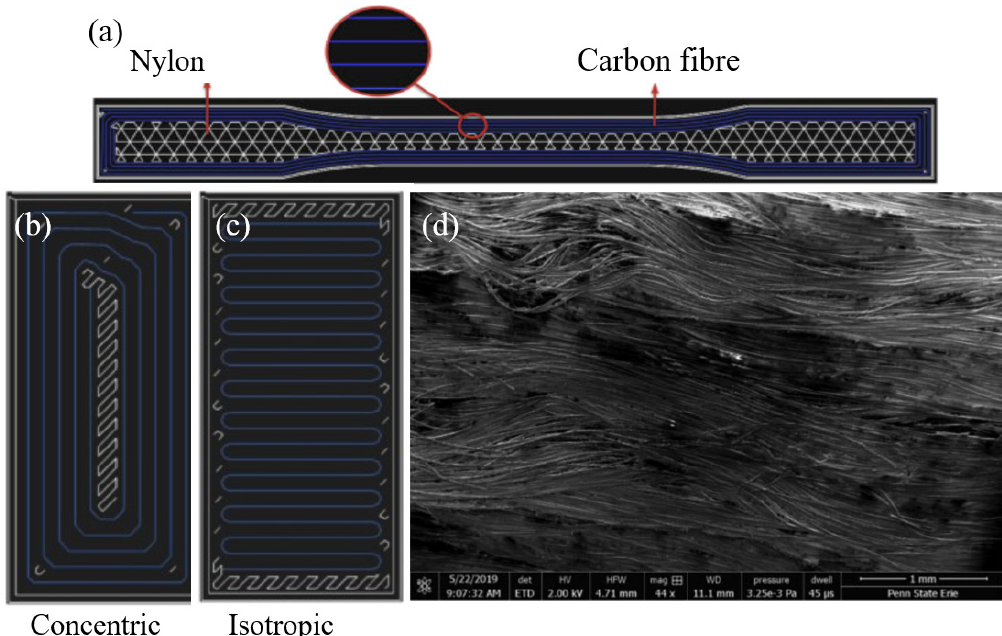
Figure 10. ( a ) Continuous carbon fibre and thermoplastic nylon filament in the tensile specimen [176]. ( b ) Concentric infill. ( c ) Isotropic infill [175]. ( d ) Continuous carbon fibre strands in a composite [148].